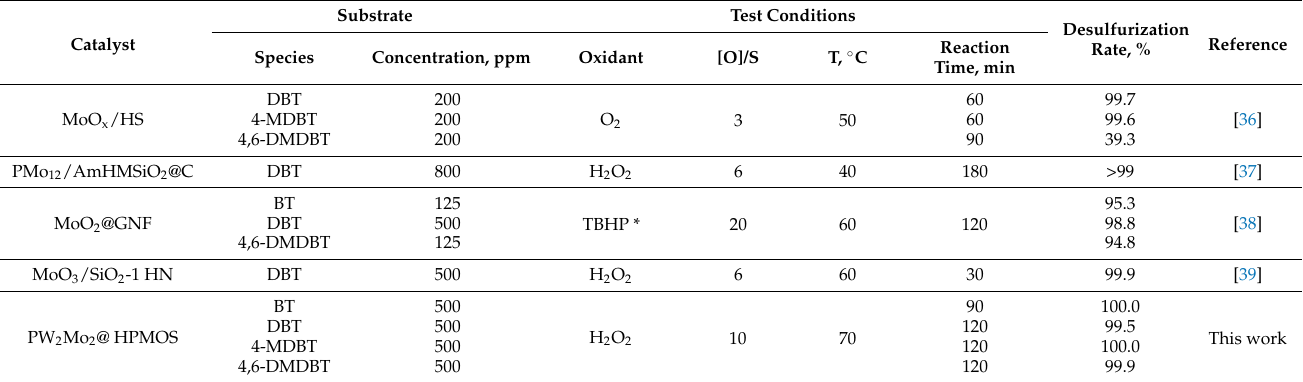
Table 2. Comparison of the desulfurization of fuel in the nanoreactor.